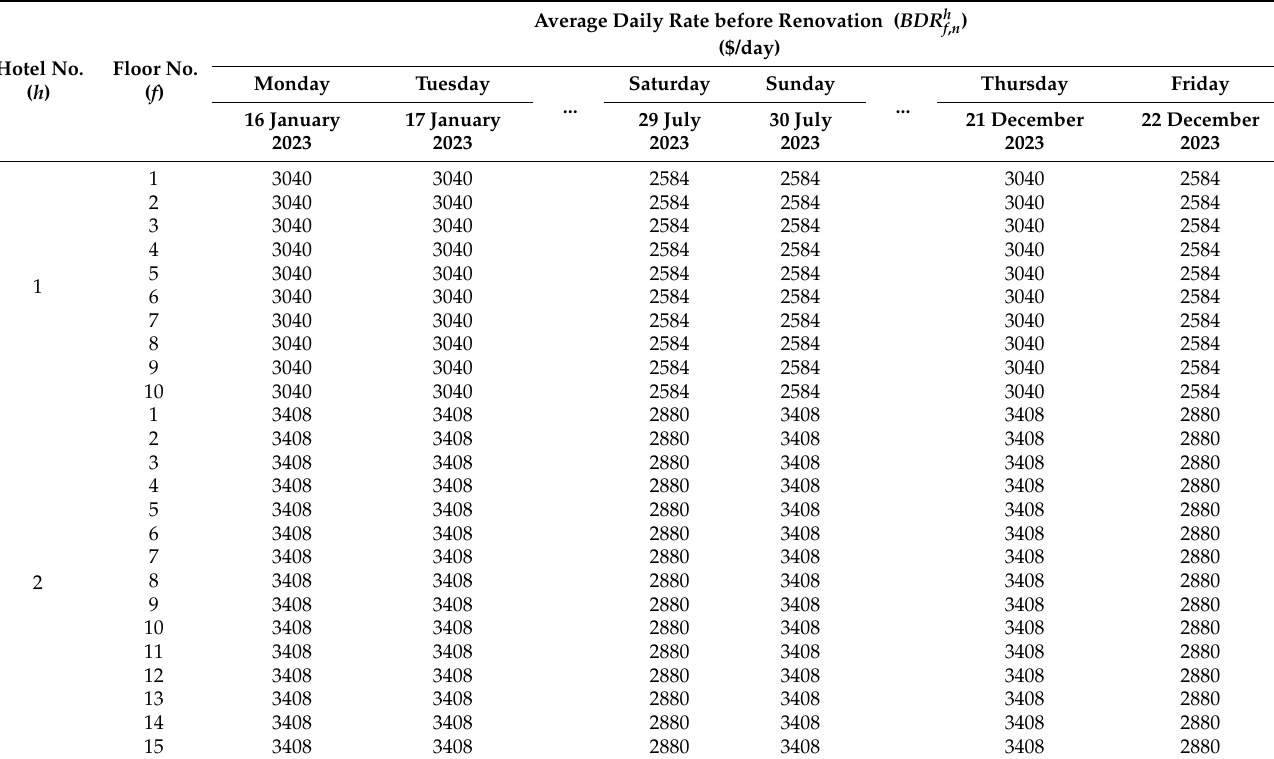
Table 6. Average daily rate before renovation for sample